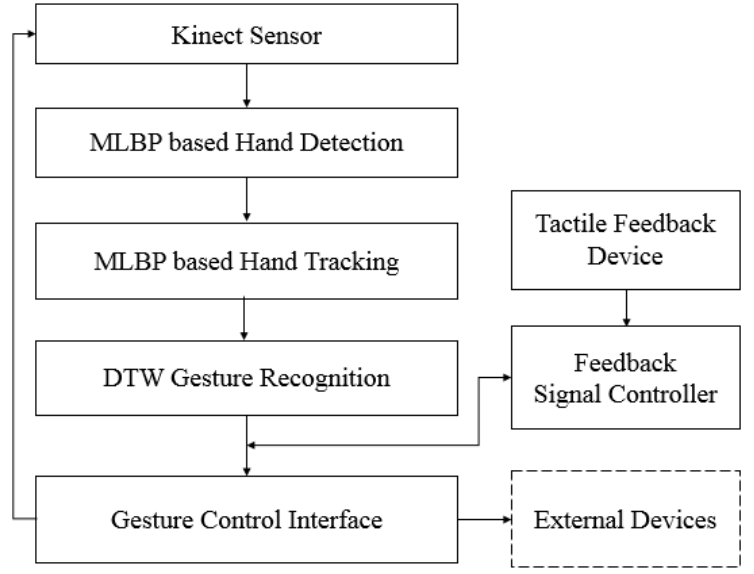
Figure 14. Block diagrams of the proposed mid-air gesture control system with tactile